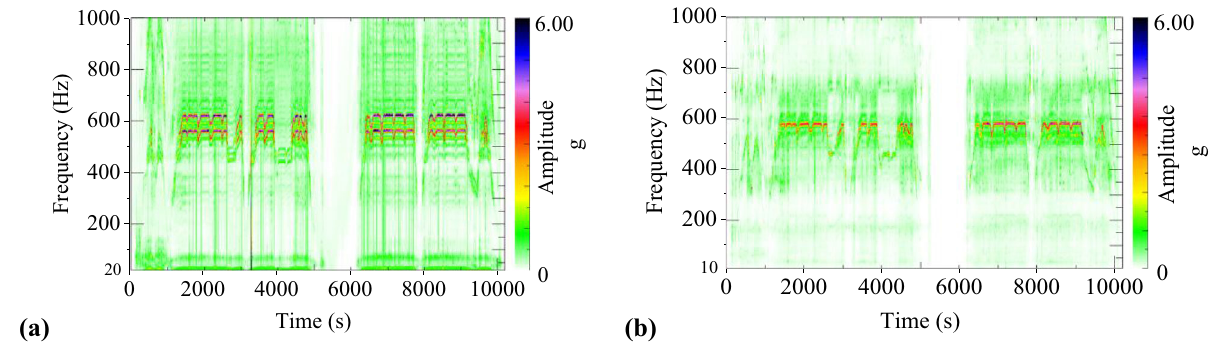
Fig. 10 Time–frequency spectrum of a wheel and b axle box accelerations of high-speed train excited by high-order wheel polygonal wear [42]